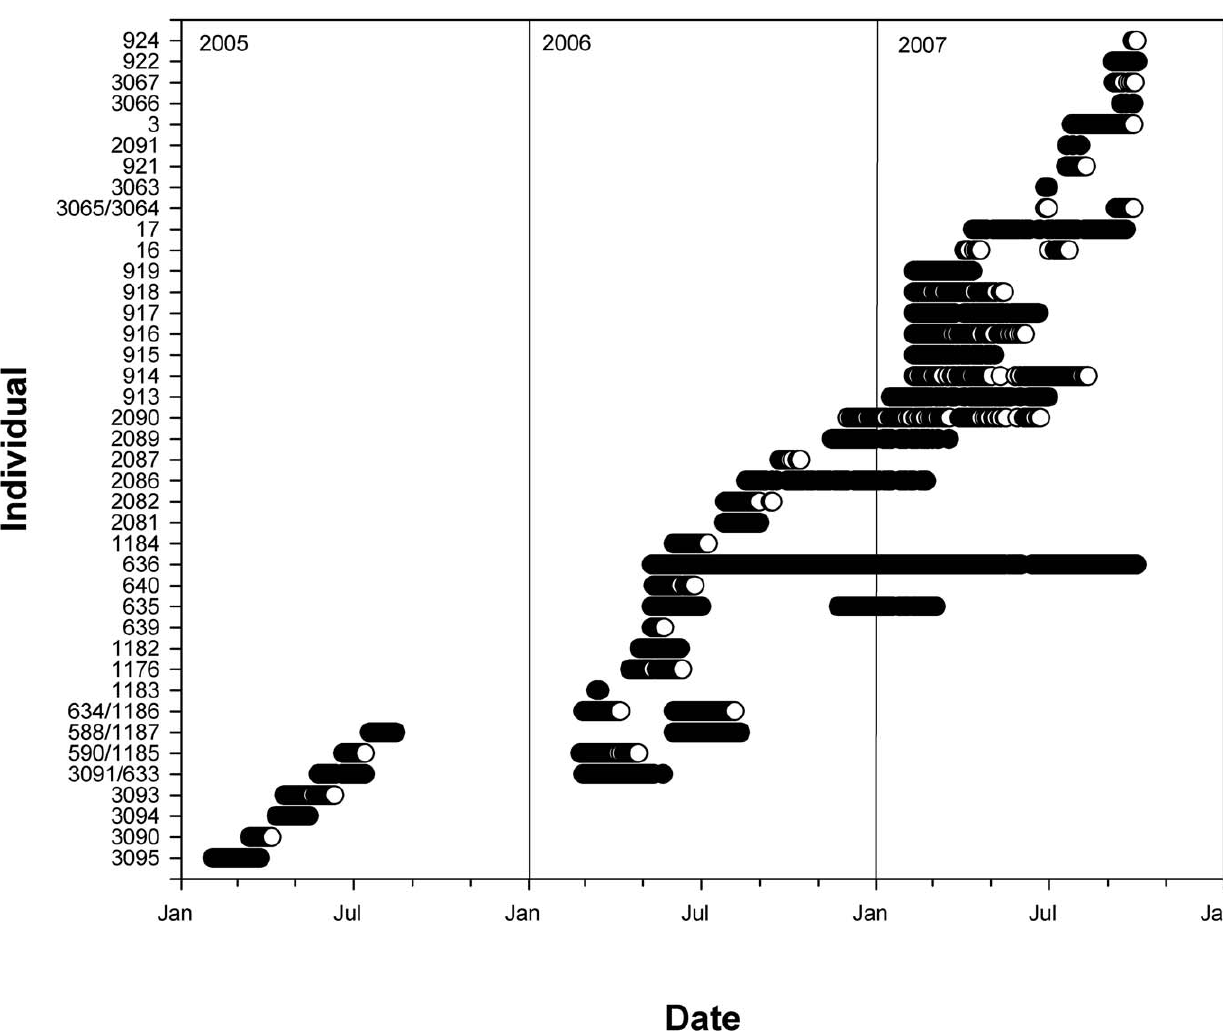
Figure 3. Presence history of the monitored Pristispectinata in the Caloosahatchee River from 2005 to 2007.